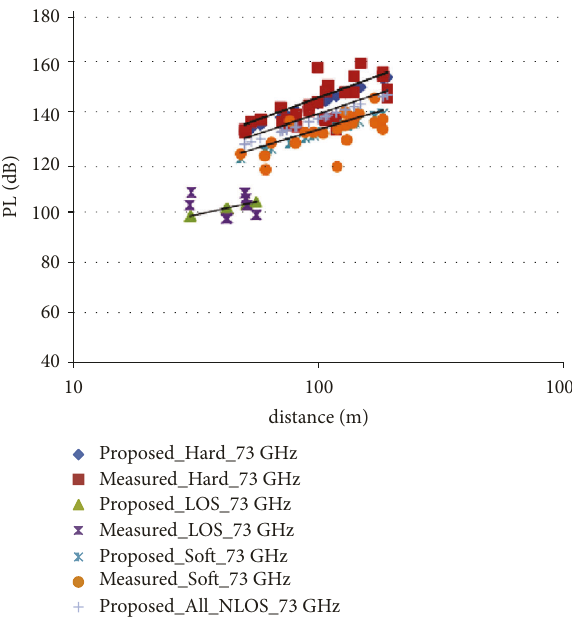
Figure 6: Proposed Model at frequency of 73GHz.